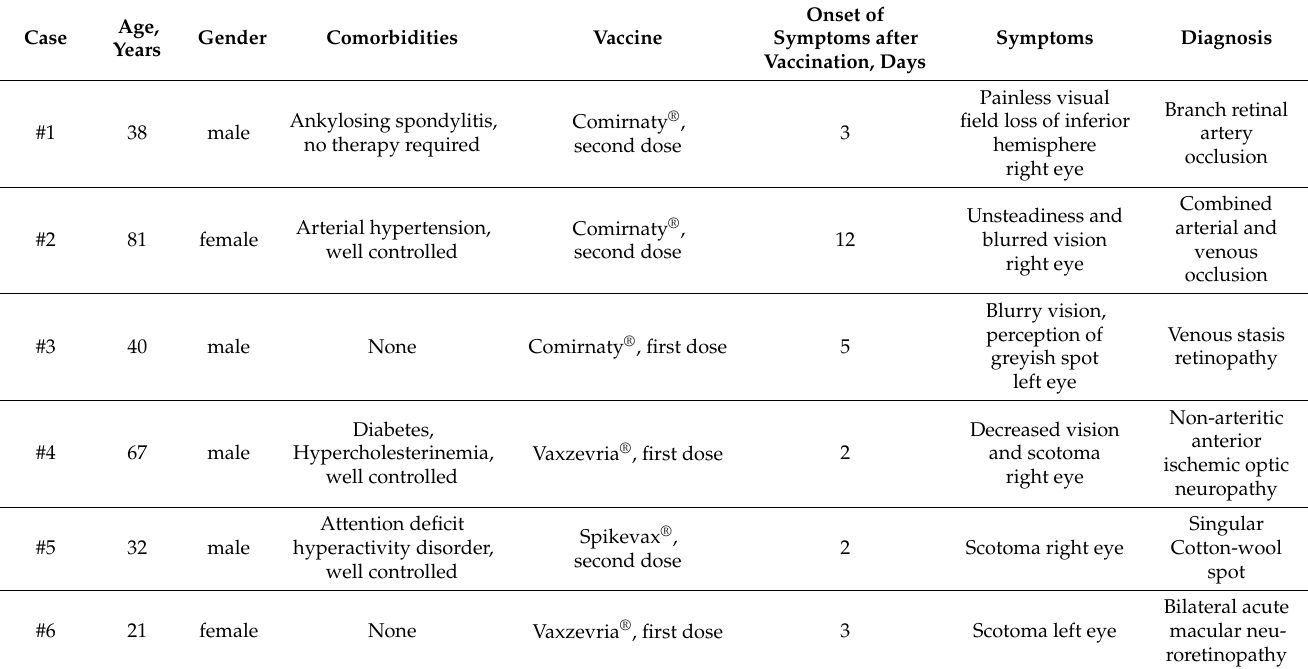
Table 1. Summary of case